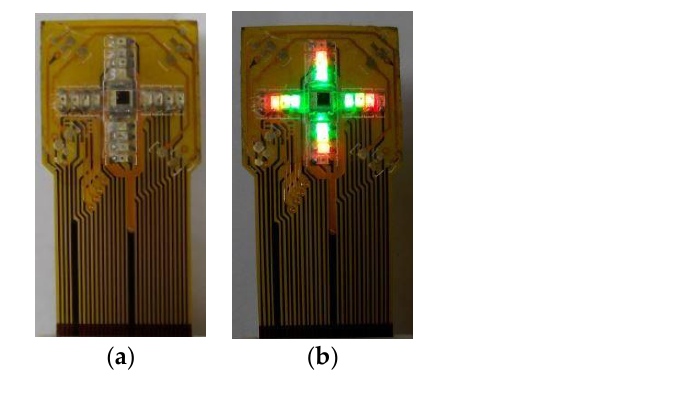
Figure 2. Photographs of the mOEPS: ( a ) in non-illuminated state; and ( b ) in illuminated state.